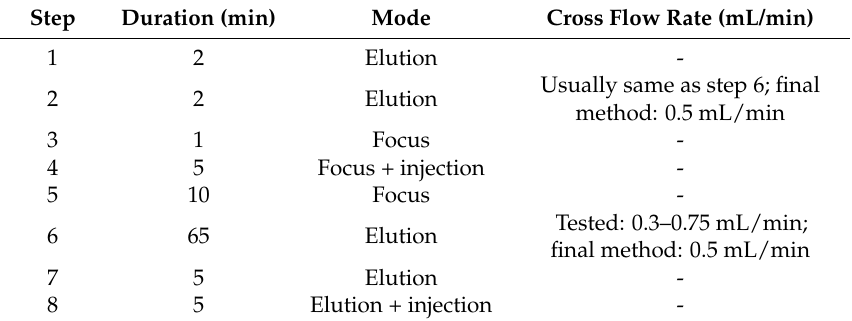
Table 1. Asymmetric flow field-flow fractionation (AF4) separation program (typical